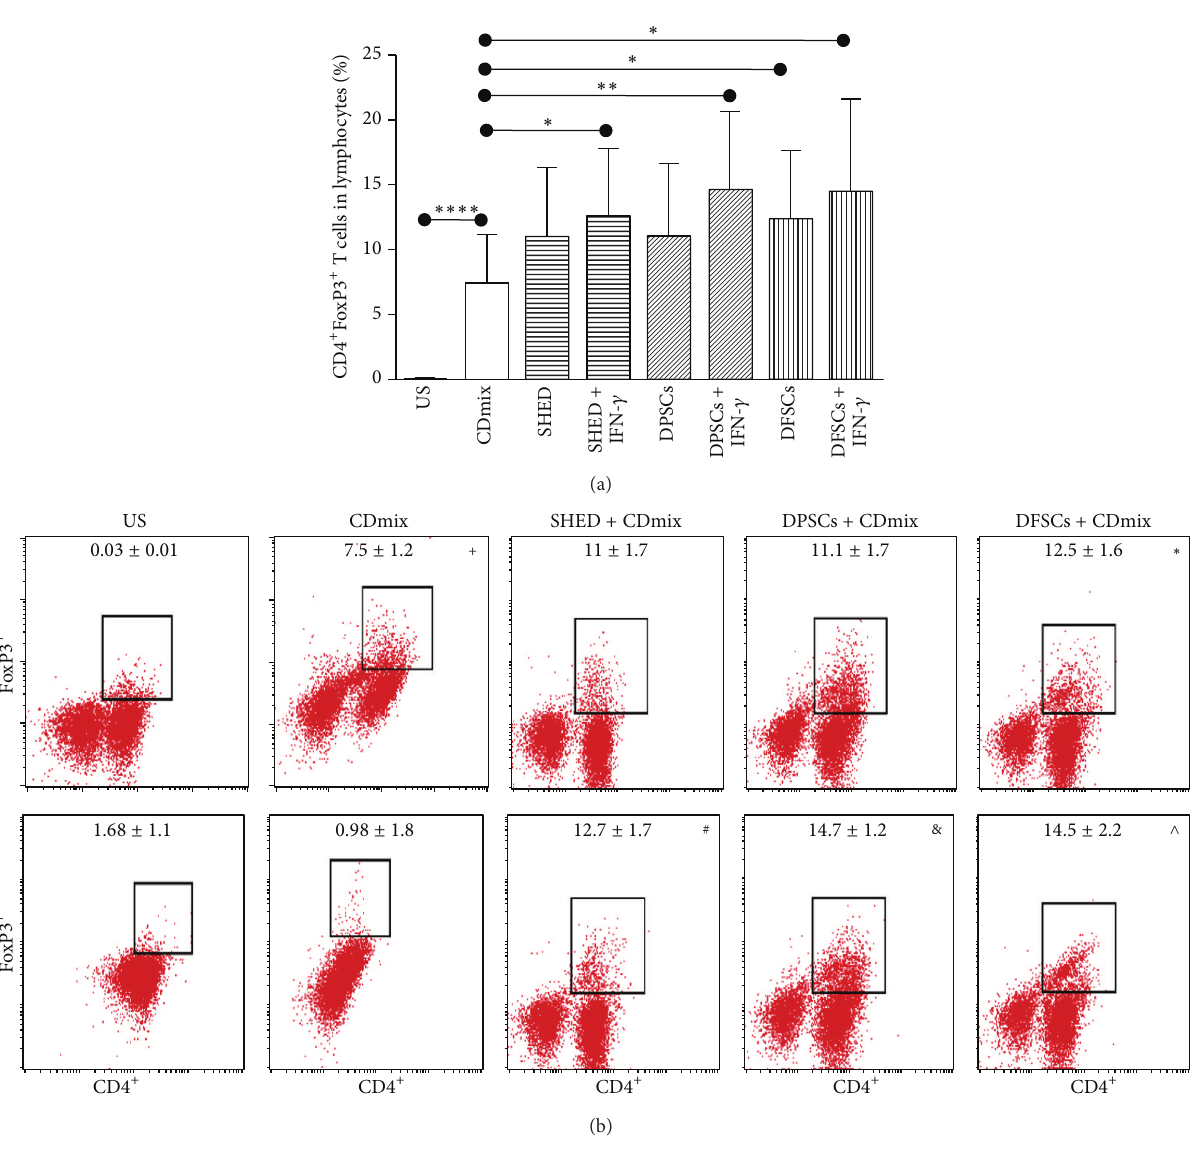
Figure 8: We therefore studied the effect of SHED, DPSCs, and DFSCs on Treg frequency. (a) Induced effects of SHED, DPSCs, and DFSCs on CD4 + FoxP3 + Treg cells were displayed statistically. (b) Induced effects of SHED, DPSCs, and DFSCs on CD4 + FoxP3 + Treg cells were displayed by flow cytometry. + 𝑃 < 0.0001 , compared with US group. ∗ 𝑃 < 0.05 , compared with CDmix group. # 𝑃 < 0.05 , compared with CDmix group. & 𝑃 < 0.01 , compared with CDmix group. ∧ 𝑃 < 0.05 , compared with CDmix